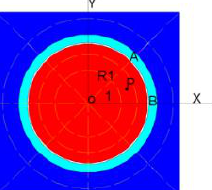
Figure 1. Material regions and flat source regions of a typical PWR pin